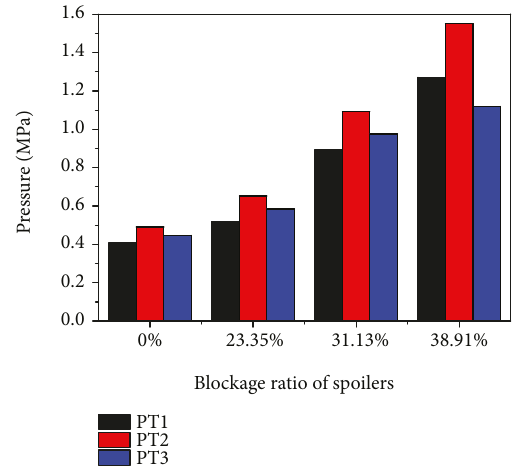
Figure 14: Peak pressures at di ff erent positions of the WRC with di ff erent blockage ratio